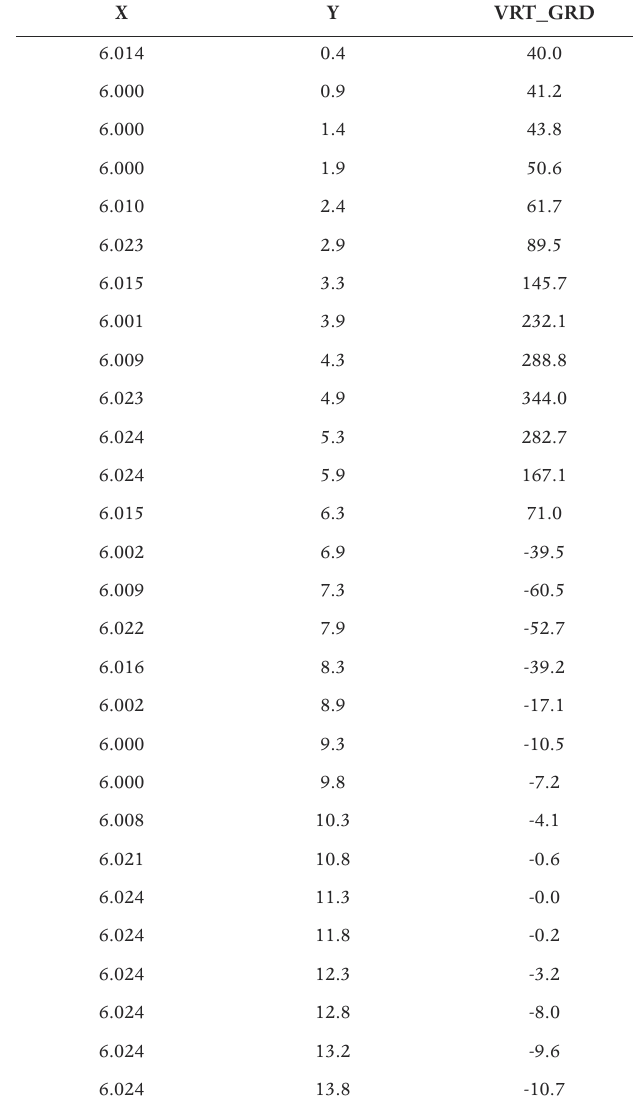
Table. 1. A sampling in (X,Y) coordinates of the vertical gradient distri- bution VRT_GRD, along a N-S oriented profile, across the magnetic anomaly due to the three buried steel drums (Figure